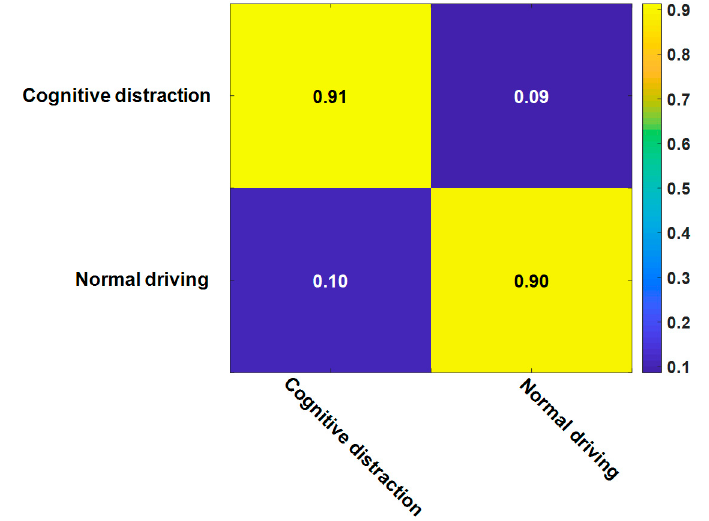
Figure 12. The confusion matrix for the attention (Atten)-BiLSTM model.